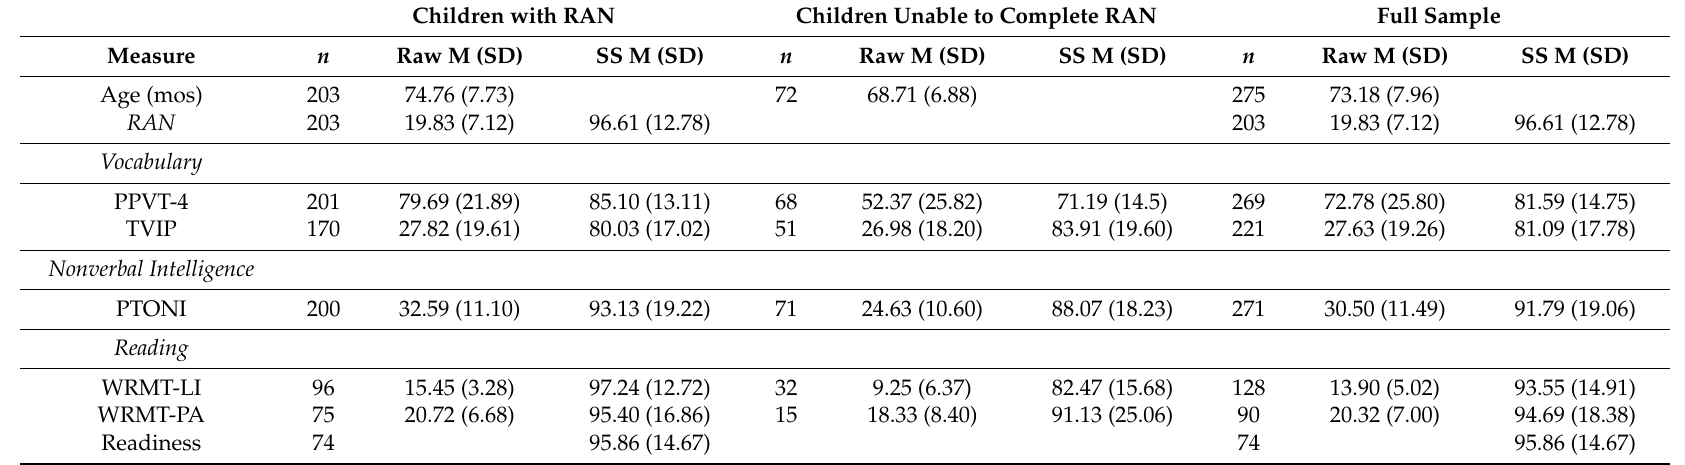
Table 4. Children’s performance in language and literacy assessment measures.